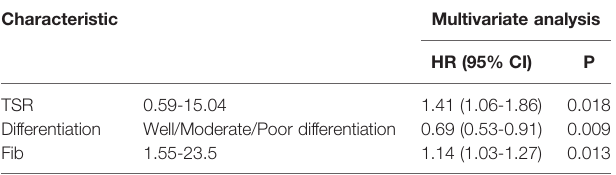
TABLE 3 | Multivariate analysis of risk factors.